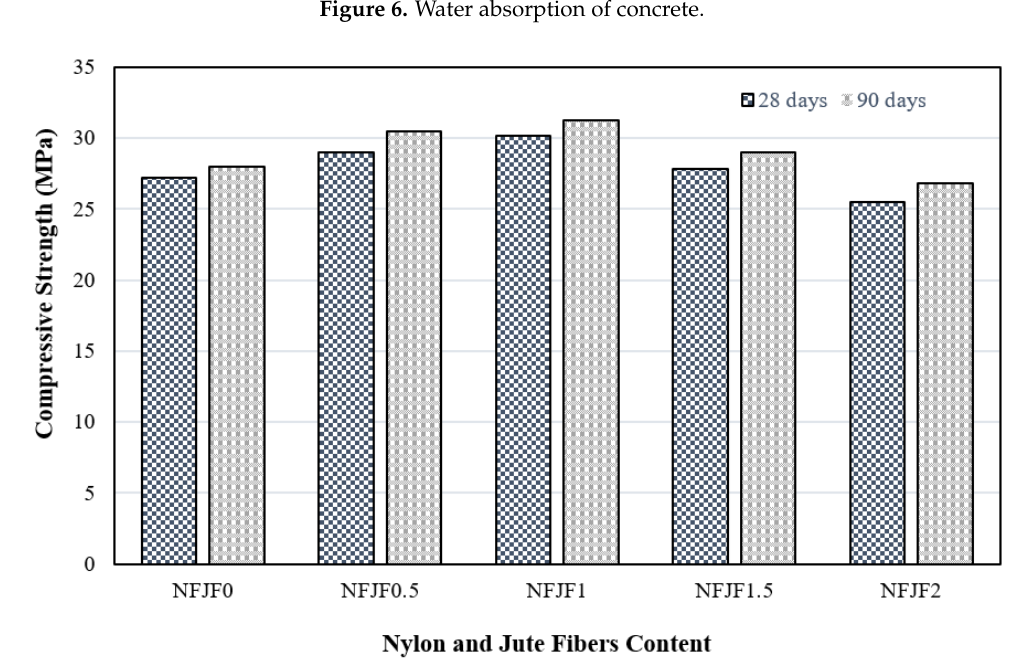
Figure 7. Compressive strength of concrete.